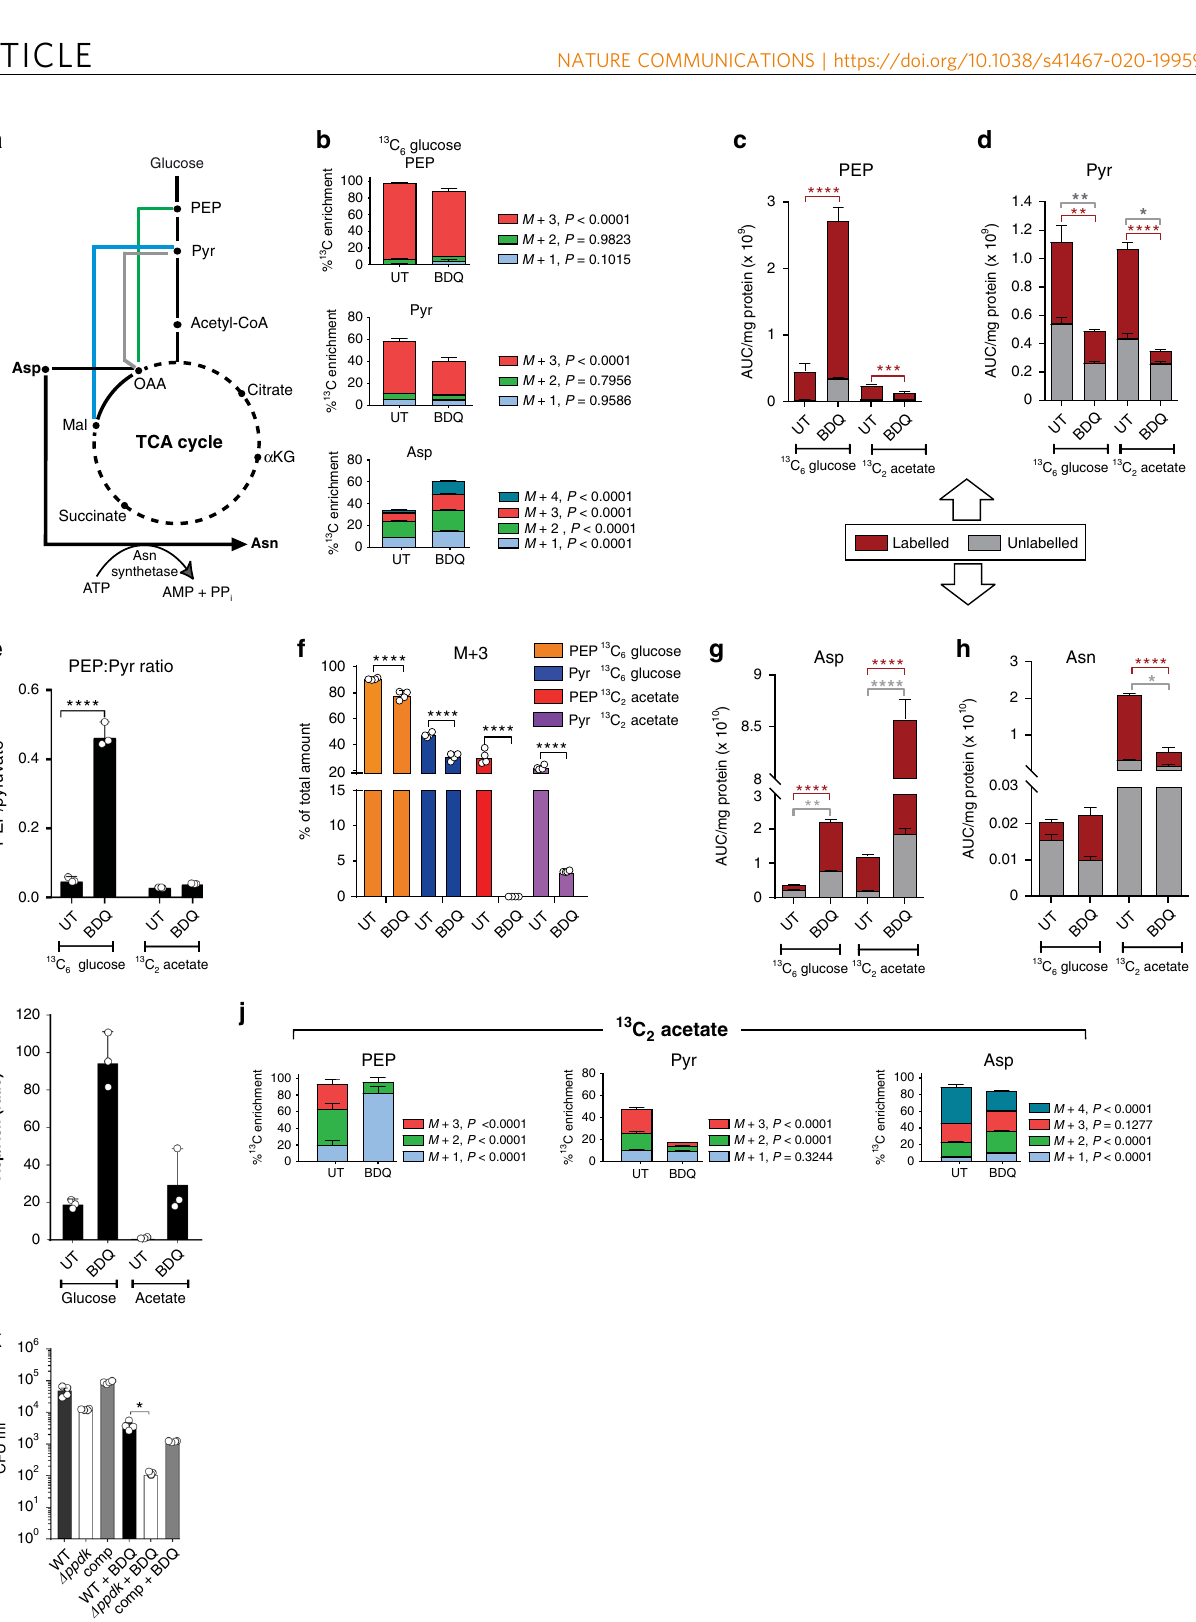
OXPHOS by BDQ heightens Mtb ’ s dependency on glycolysis and substrate-level phosphorylation in an attempt to conserve energy and enhance ATP production, consistent with the delayed cidal effect of BDQ on Mtb 9 . BDQ dysregulates pyruvate metabolism and gluconeogenesis . PEP and PYR are the two fi nal products of glycolysis and enter the